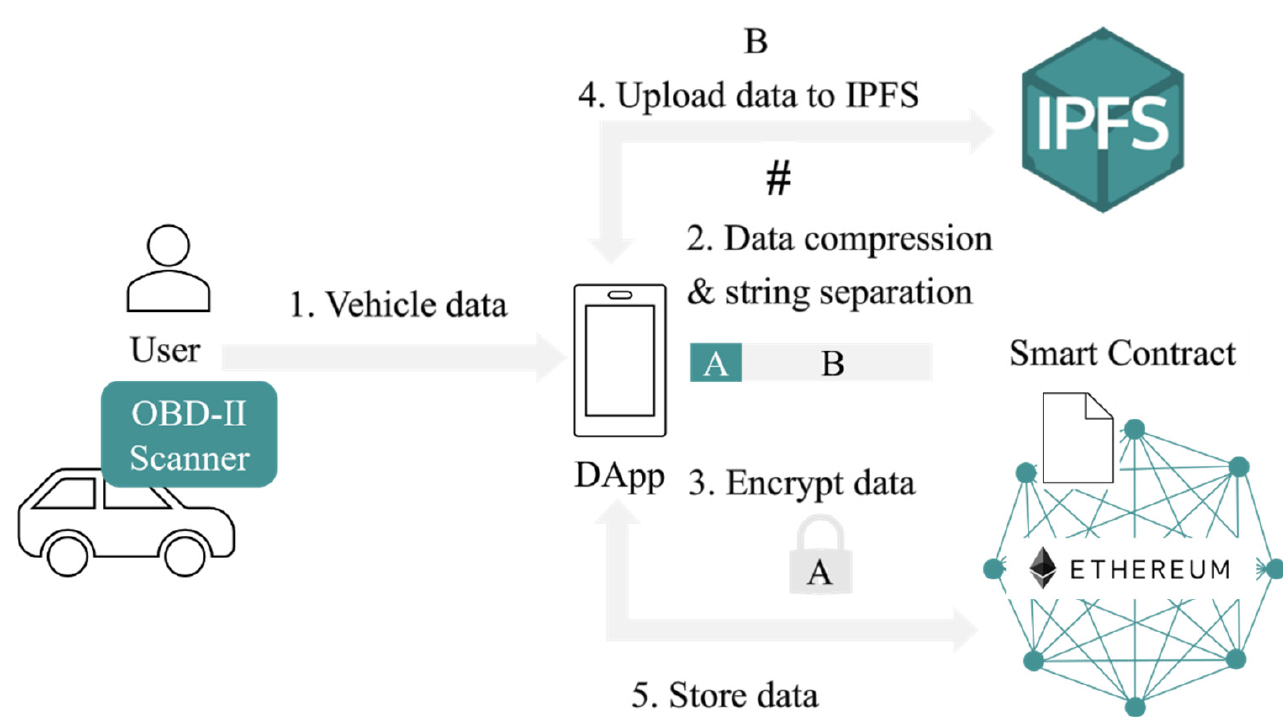
Figure 3. Process of storing data.